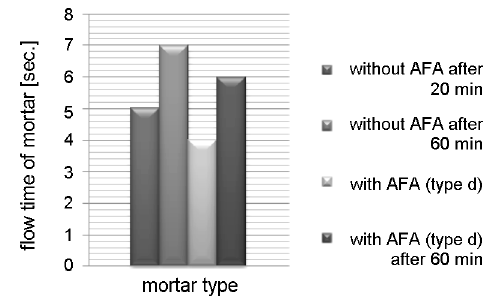
Fig. 6. The influence of the type of AFA on the flow time of mortar mixes (after 20 and 60 minutes)